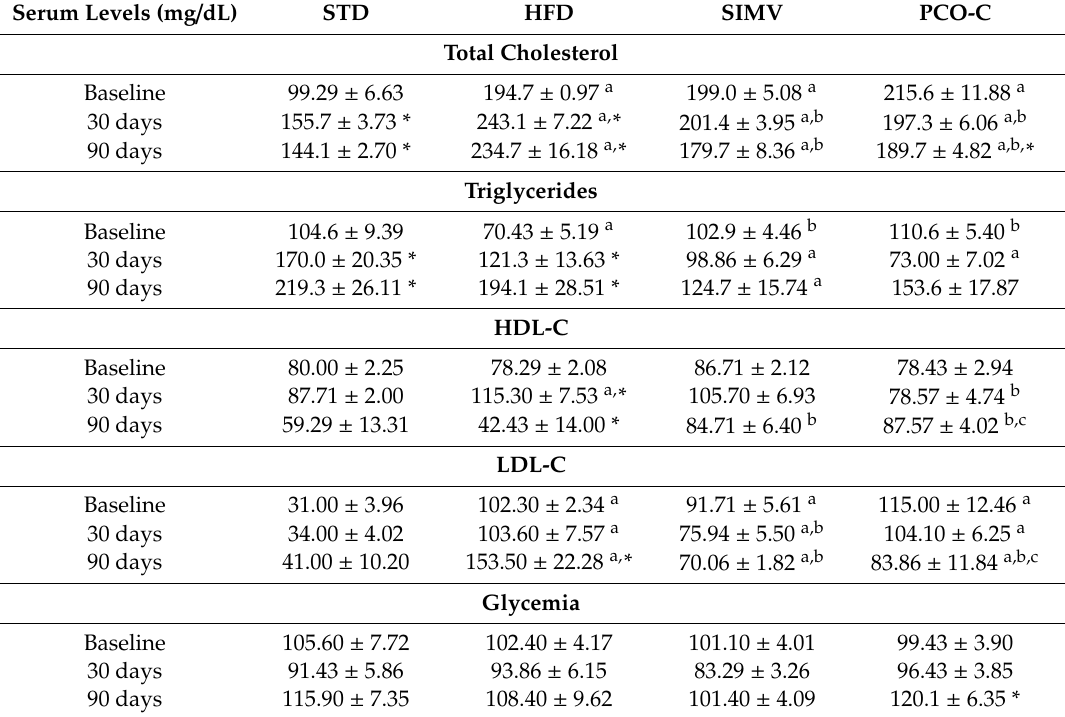
Table 5. E ff ects of PCO-C and simvastatin treatment on serum levels lipids and glycaemia in experimental mice fed either a high fat diet (HFD) or standard diet (STD) for 30 and 90 days. Serum Levels (mg / dL) STD HFD SIMV